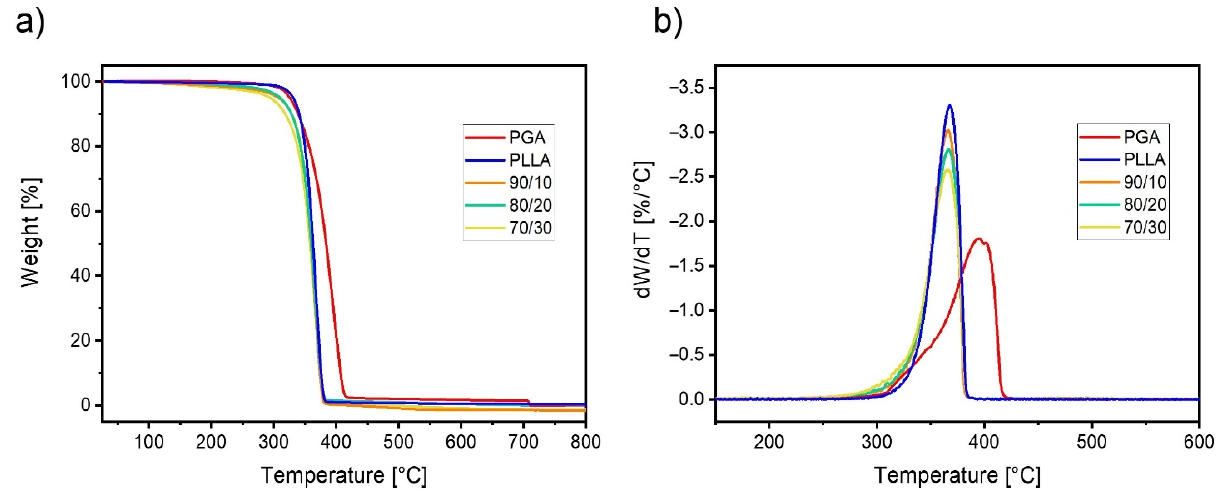
Figure 6. Mass loss versus temperature ( a ) and its derivative ( b ) for neat PLLA, PGA, and their blends at the indicated compositions.